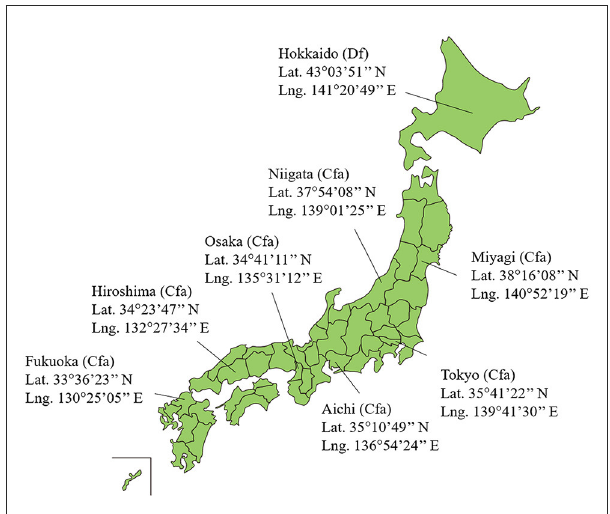
FIGURE1 Location of eight prefectures in Japan selected for this study. Japan includes 47 prefectures. The Köppen climate classification in each prefecture are also